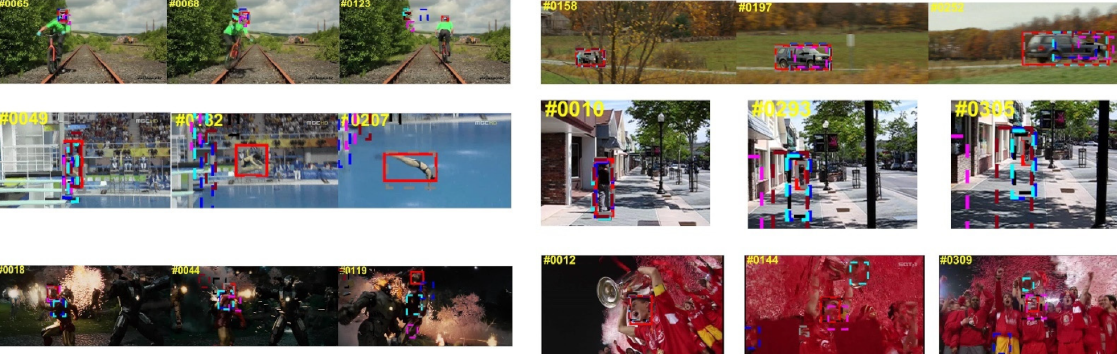
Figure 6. Visualization of the qualitative analysis results of SiamMFC and the remaining seven state-of-the-art trackers on the OTB dataset.